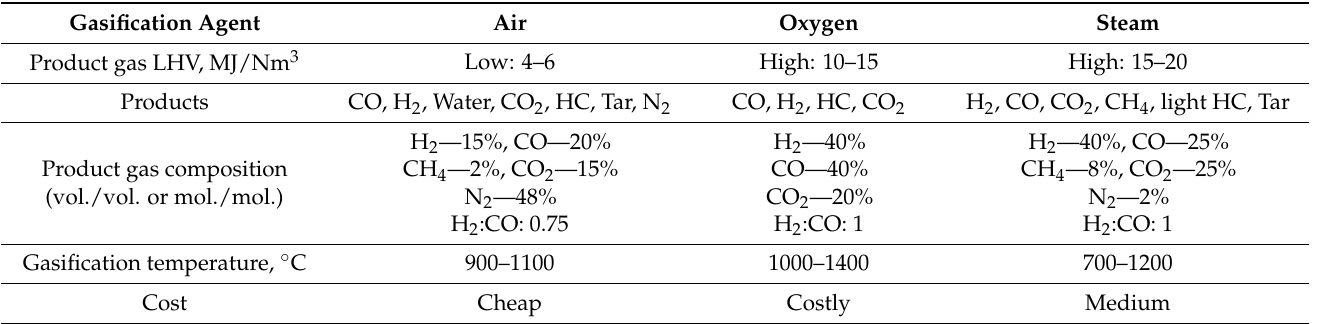
Table 5. Comparison of gasification process using different gasification agents